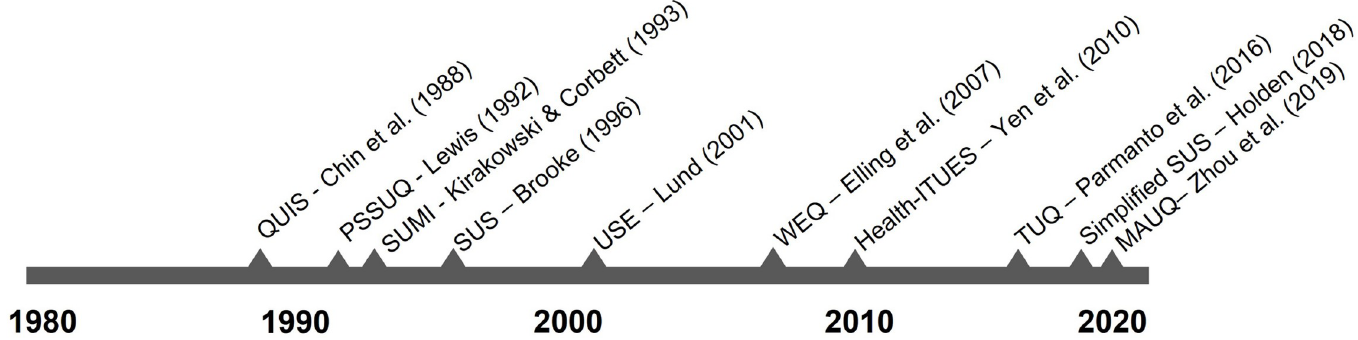
Fig 1. Timeline of the development of usability questionnaires.